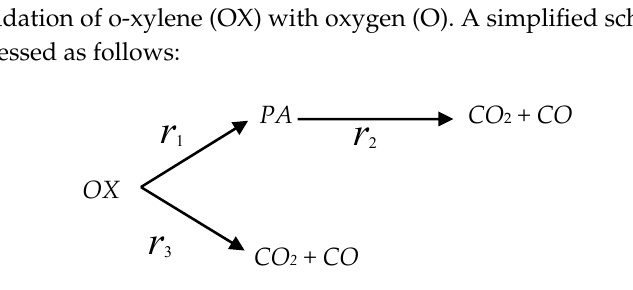
Figure 13. Scheme of a multistage adiabatic reactor (endothermic reaction). ( left ) reactor setup; ( right ) temperature profile.